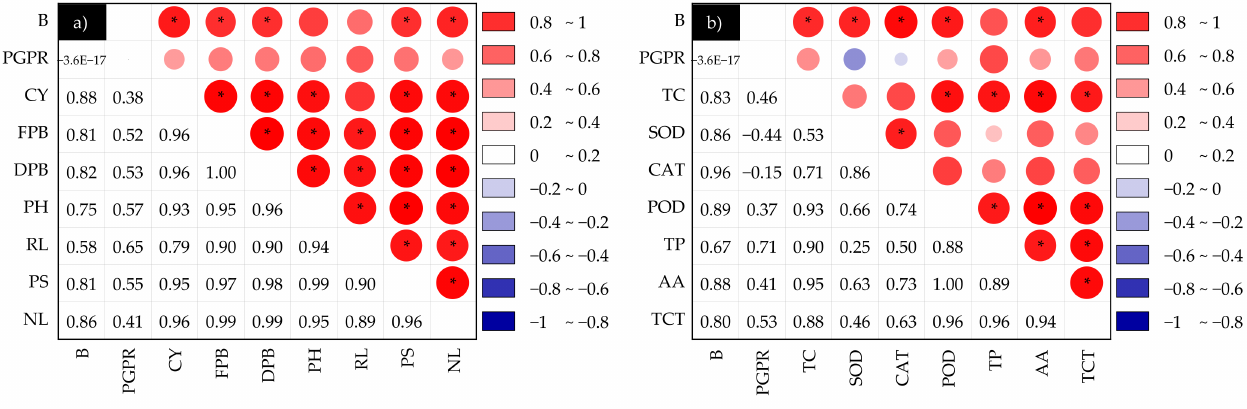
Figure 4. Correlation between spent mushroom (SMS)-based biochar and PGPR treatments on ( a ) growth, yield ( b ) biochemical, and enzyme activity characteristics of cauliflower ( B. oleracea ) (B: spent mushroom substrate biochar dose; PGPR: plant growth-promoting rhizobia; CY: crop yield; FPB: fresh plant biomass; DPB: dry plant biomass; PH: plant height; RL: root length; PS: plant spread; NL: number of leaves; TC: total chlorophyll; SOD: superoxide dismutase; CAT: catalase; POD: peroxidase; TP: total phenolics; AA: ascorbic acid; TCT: total carotenoids: *: correlation is significant at p <